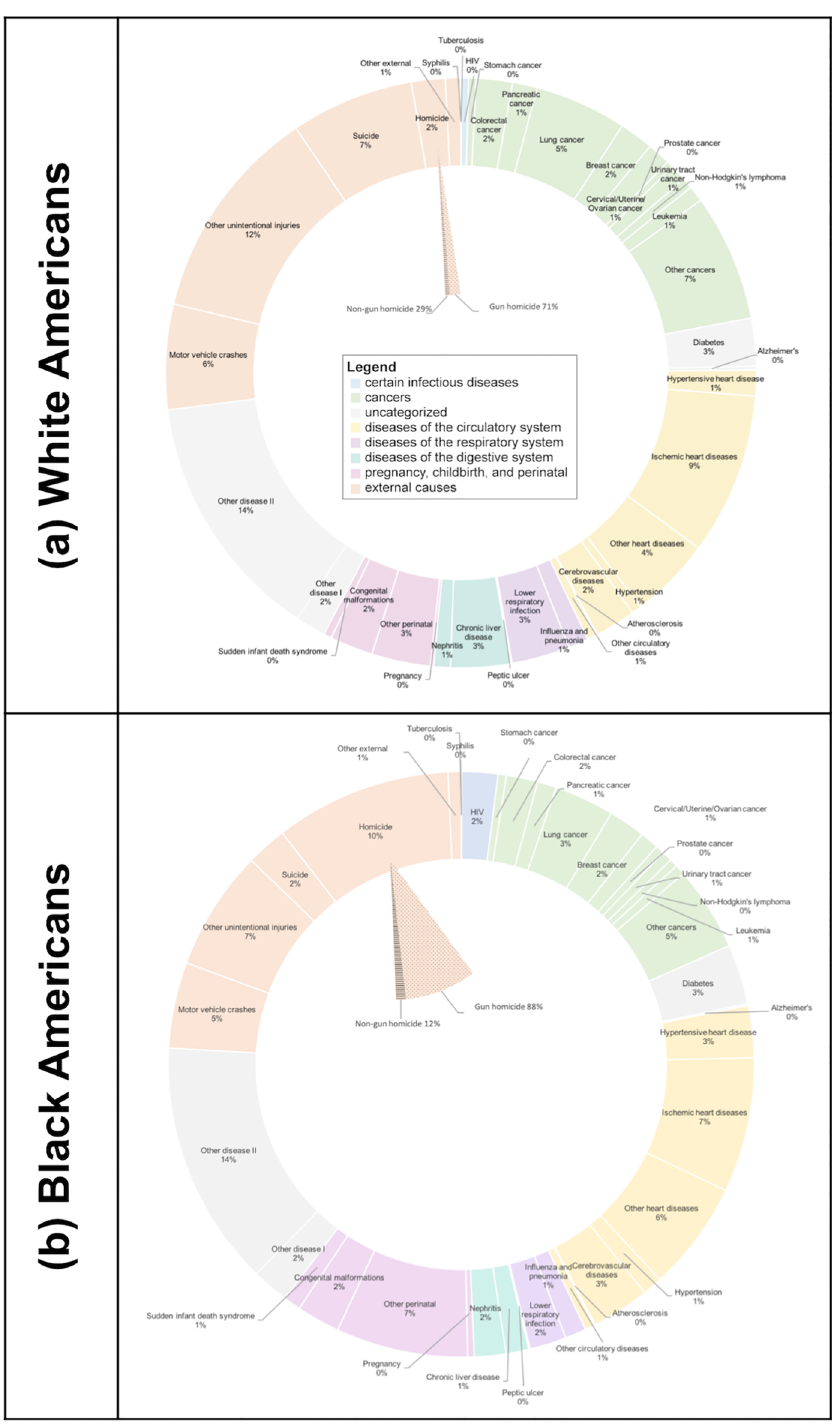
Fig 1. Proportion of potential yearsof life lost attributable to each of 39 causes of death, stratified by white and black race: United States 2015.